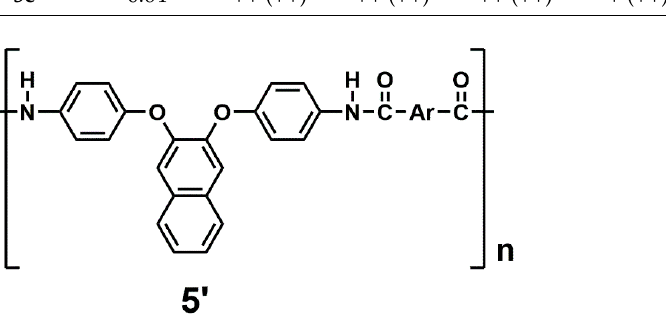
Table 1. Inherent Viscosity a and Solubility Properties b of